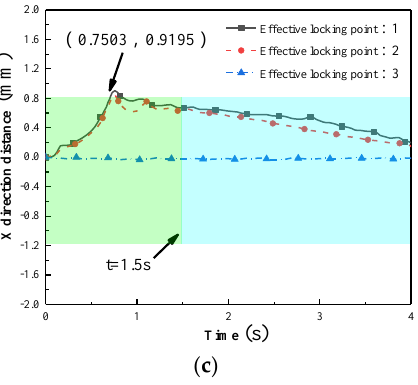
Figure 15. Variation of three-way distances during docking and locking with different numbers of